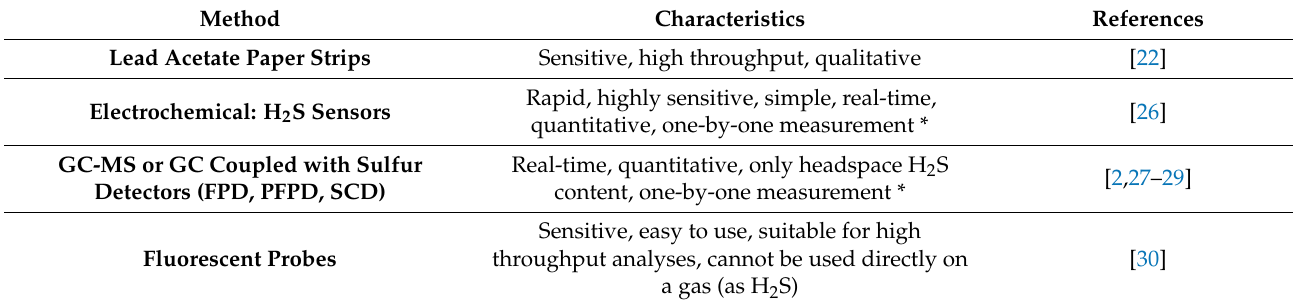
Table 1. Available H 2 S measurement